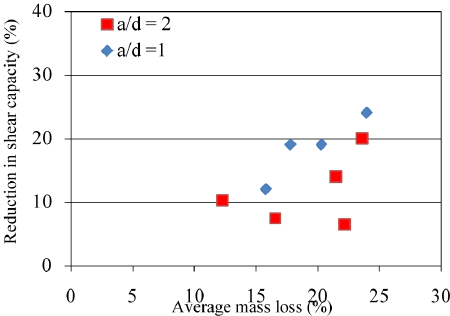
Fig. 10. Variation of reduction in shear capacity with average mass